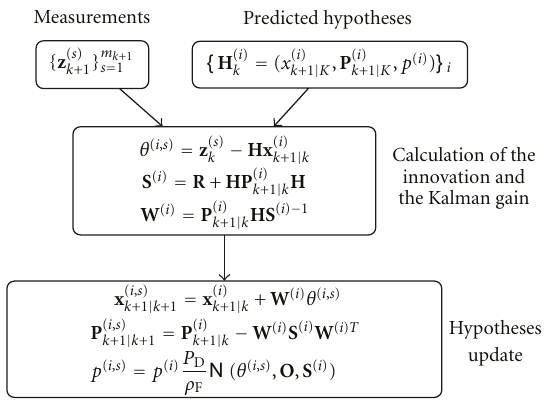
Figure 5: Measurement update step of the MHT: for each at time t k and each measurement z ( s ) hypothesis H ( i ) k = ( x ( i ) , P ( i ) , p ( i ) ) is hypothesis H ( i ) k +1 k +1 | k k +1 | k